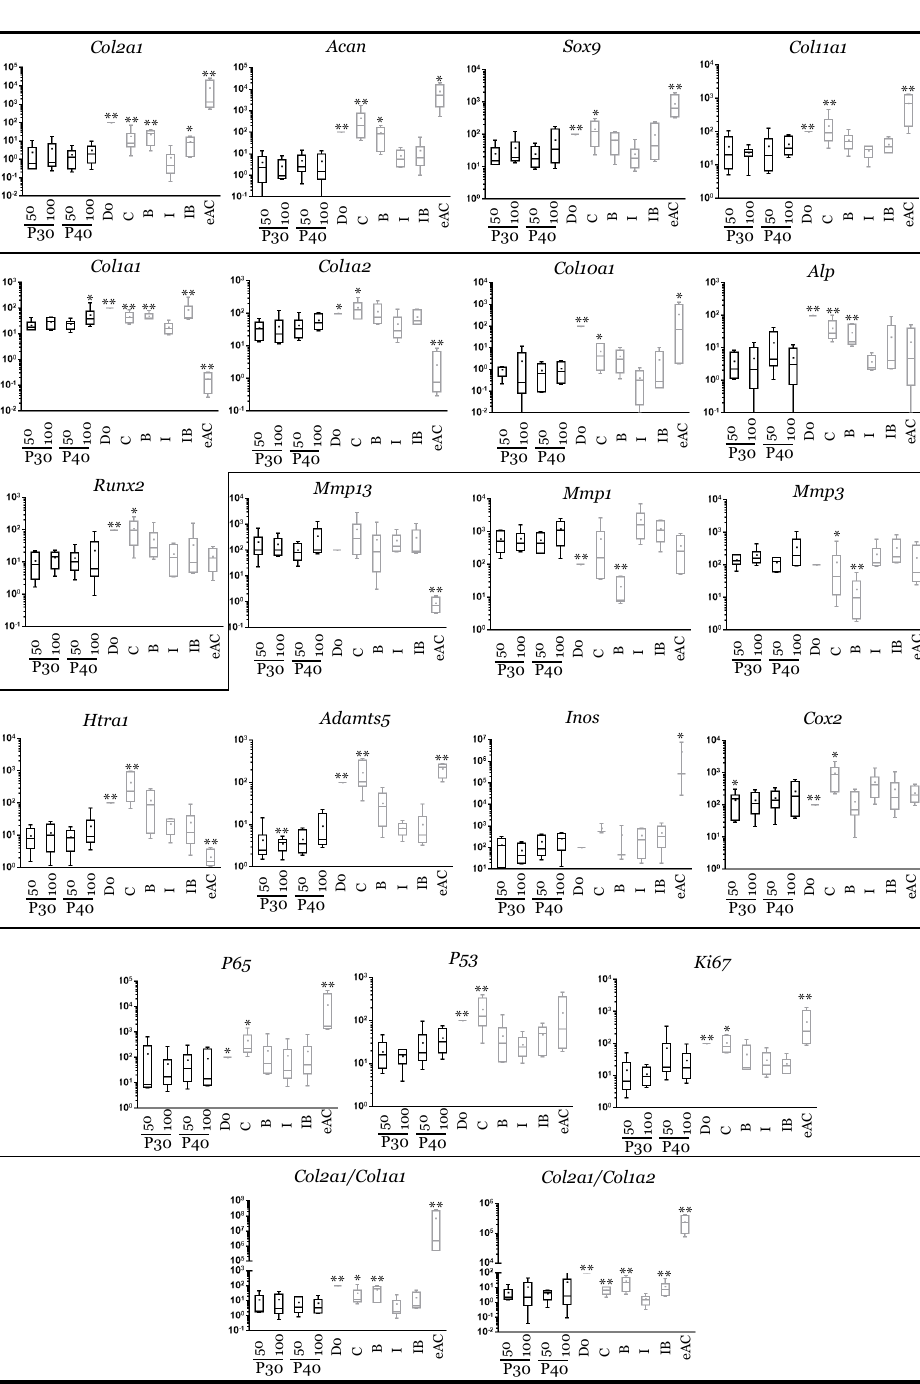
Figure 10. mRNA expression in equine articular chondrocytes treated with Promerim ® 30 and 40 used at high concentrations in the presence of IL-1. Equine articular chondrocytes were grown in type I/III collagen sponges at the third passage (P3). They were incubated during 7 days under hypoxia in the absence (C: control) or both the presence of IL-1 + P30 and IL-1 + P40, or BMP-2 alone (B), or IL-1 alone (I), or BMP-2 together with IL-1 (IB). The Promerim ® were used at the concentrations of 50 and 100 µg/mL. The mRNAs were estimated using RT-qPCR after normalization with respect to the β -actin reference gene. Transcript expression is shown in arbitrary units. The Col2a1 : Col1a1 and Col2a1 : Col1a2 ratios are given. The results are shown as box plots (median, quartiles, extreme values) and the significance of the values between the different treatments and the control case (IL-1) was tested using a Mann–Whitney test (* p < 0.05; ** p < 0.01); n = 6. eAC: mRNA extracts obtained from equine articular chondrocytes released from cartilage after overnight enzymatic digestion were used as controls. D0: cells seeded in sponges and arrested after 16 h of incubation. P30 and P40: Promerim ® 30 and